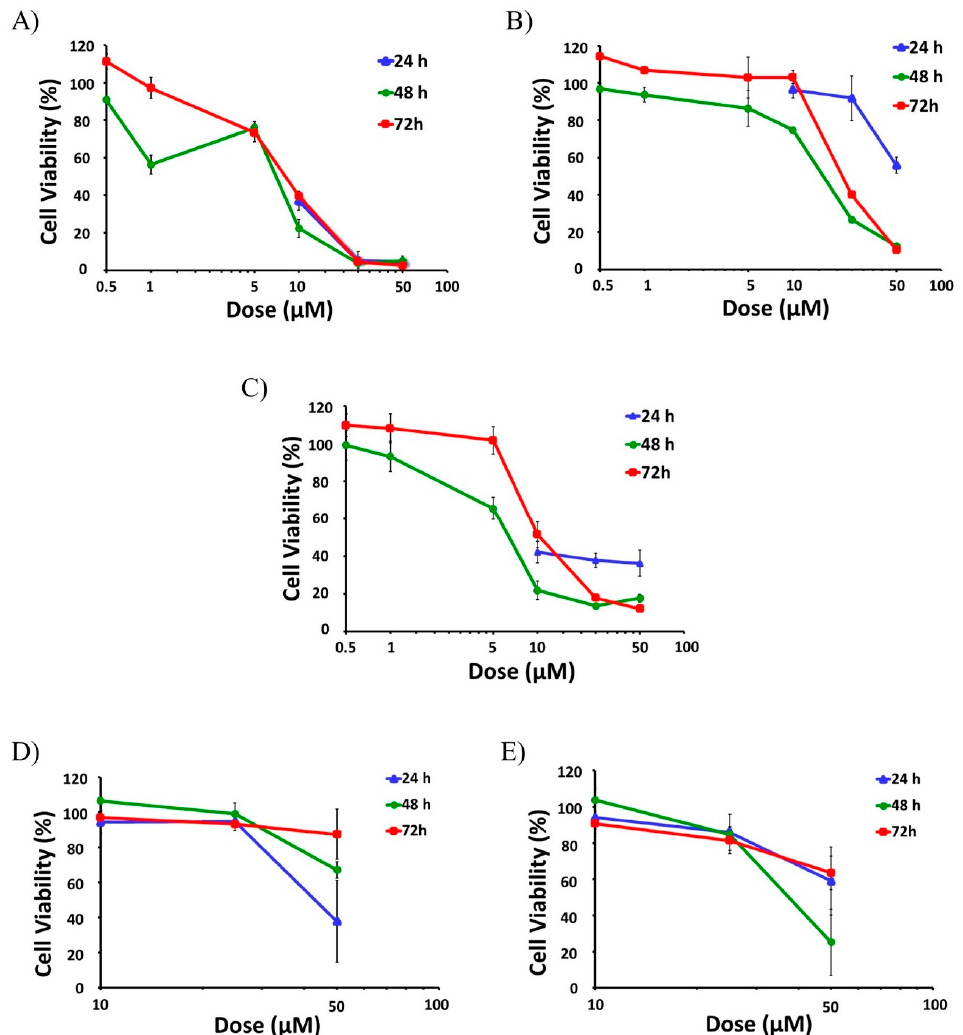
Figure 2. Anti-leukemic effect of Brassica spp. phytochemicals in HL-60 cells. The screening of the potential anti-leukemic activity of the Brassica spp. phytochemicals were initially done with high doses (10 µM, 25 µM, and 50 µM) of all compounds for 24, 48, and 72 h. Then, the selected more active compounds (SFN, CQA, and C3G) were subjected to further dose-response analysis by testing lower doses (0.5 µM, 1 µM and 5 µM) at 48 and 72 h. Data represents % of cell viability ± SD of HL-60 human leukemia cells in the presence of active Brassica-derived compounds measured by MTT assays ( n = 3, three independent experiments performed in triplicate). ( A ) Anti-leukemic potential of SFN. ( B ) Anti-leukemic potential of CQA. ( C ) Anti-leukemic potential of C3G. ( D ) Anti-leukemic potential of I3C. ( E ) Anti-leukemic potential of DIM. SFN, sulforaphane; CQA, Chlorogenic acid; C3G, cyanidin-3-glucoside chloride; I3C, indole-3-carbinol; DIM, 3,3 ′ -Diindolmethane. In the case of the indolic group of compounds, including glucobrassicin (GBS), I3C, and DIM, only I3C and DIM showed significant antiproliferative effects. While I3C was able to reduce the viability of the cells down to 38%, but just at the shorter time (24 h) with the maximum dose (Figure 2D), DIM showed a mild effect with the higher dose at all the three time-points assayed, reaching a maximum cytotoxicity of 75% at 48 h (25% viability), (Figure 2E). GBS did not show any effect on cell viability in any experimental condition.